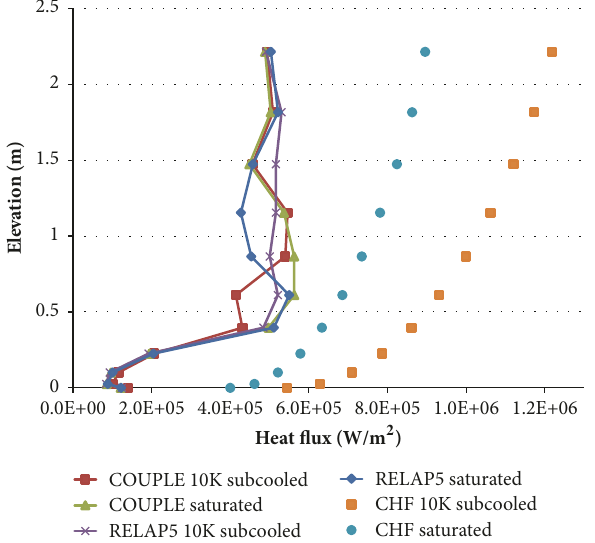
Figure 14: Maximum RPV heat flux to the ex-vessel for each case.